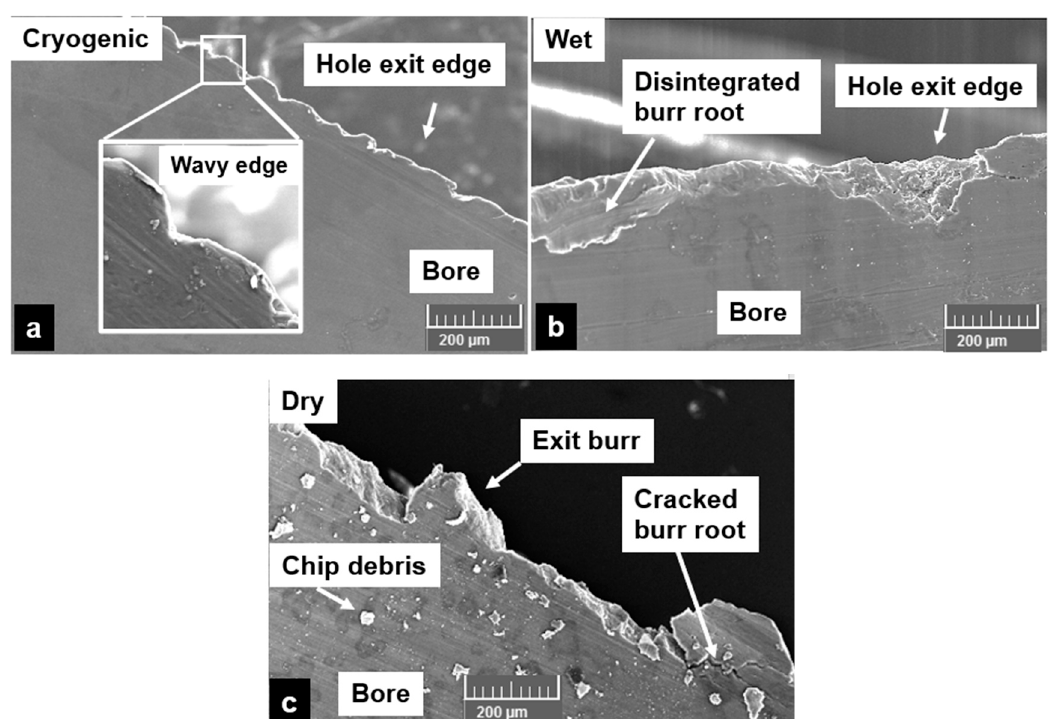
Figure 10. Burr types at the exit side of the hole: ( a ) cryogenic, ( b ) wet, ( c ) dry.